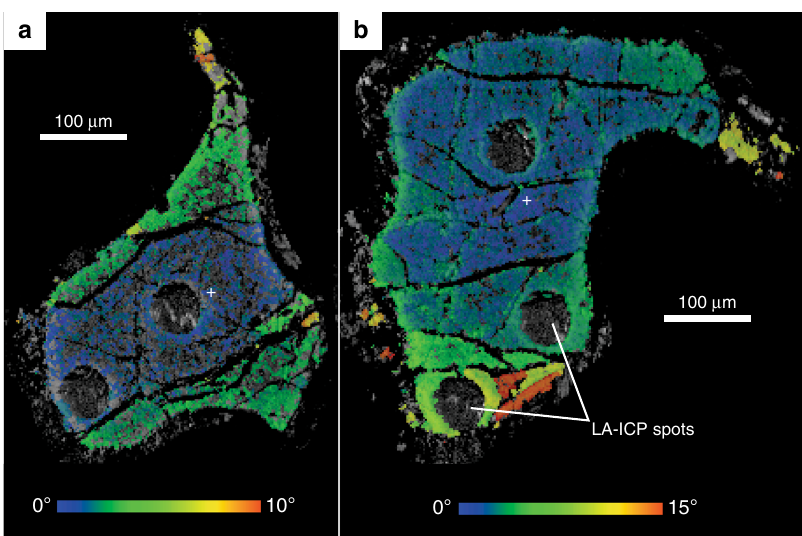
Fig. 4 EBSD microstructural data from two Cr-spinel grains from sample A4D. Images comprise greyscale image of EBSD pattern quality overlain by misorientation maps measured relative to the orientation of spinel lattice at the position shown by the white cross. For grain a total misorientation is 10°, for b the total misorientation is 15°. The change in misorientation in each grain corresponds to presence of late fractures seen in the pattern quality image. Total misorientation within individual fracture-bound regions of the grain is <1°, indicating that there is no plastic deformation within the